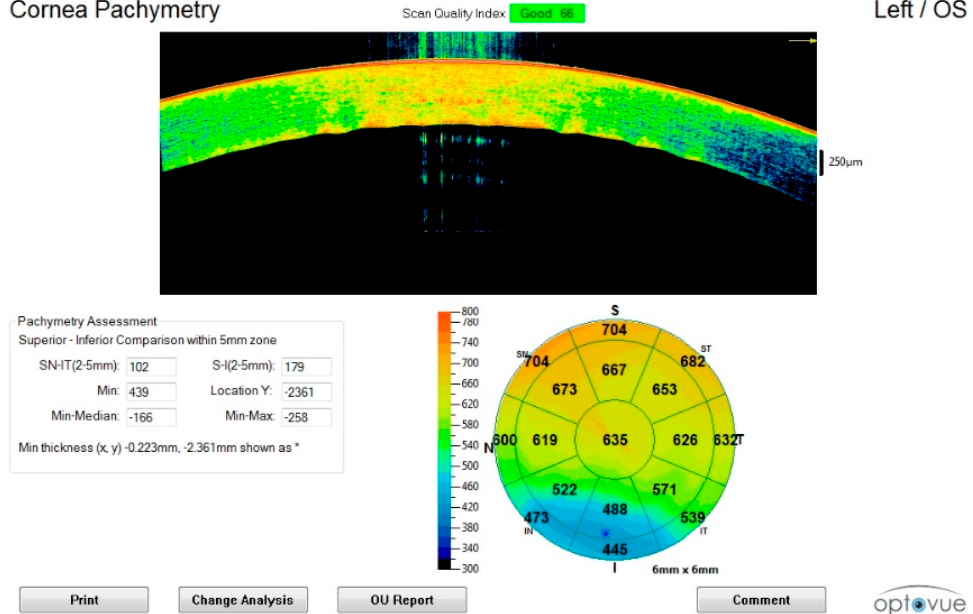
Figure 1. Corneal scan in the early postmortem interval (sixth hour). The initial thickening, disappearance of the tear film, outer hyper-reflectivity, and initial formation of endothelial humps can be observed.